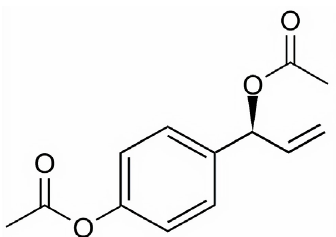
FIGURE 1 - Chemical structure of